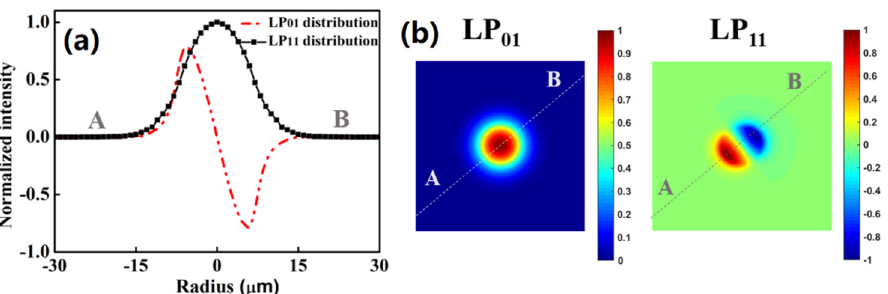
Figure 2. Calculated electric fields of guided LP mode LP 01 and LP 11 at 1550 nm in the optimized MSI 2-LP-mode fiber. ( a ) Two-dimensional mode profiles, and ( b ) electric field mode pattern.